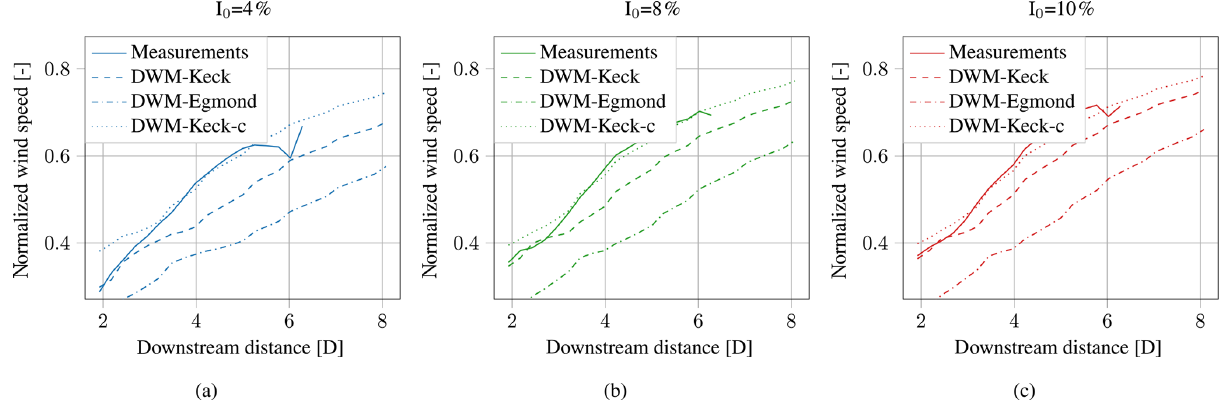
Figure B1. Comparison of measurements and simulations of the minimum wind speed deficit in the HMFR for different turbulence intensi- ties. The recalibrated model is denoted DWM-Keck-c.